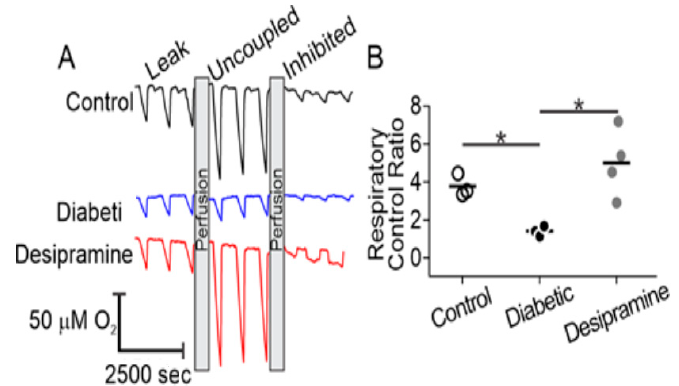
Figure 4. Microrespirometric analysis of human RPE cells. ( A ) Representative oxygen concentration traces of control (black), diabetic (blue), and desipramine-pretreated diabetic (red) RPE cells. Respirometry was performed in the presence of oligomycin (leak), carbonyl cyanide m-chlorophenylhydrazone (CCCP, uncoupled), and potassium cyanide (KCN, inhibited). See text for details; ( B ) Respiratory control ratios of control (white circles), diabetic (black circles), and desipramine-pretreated diabetic groups (gray circles). * p < 0.05, n = 3–4.